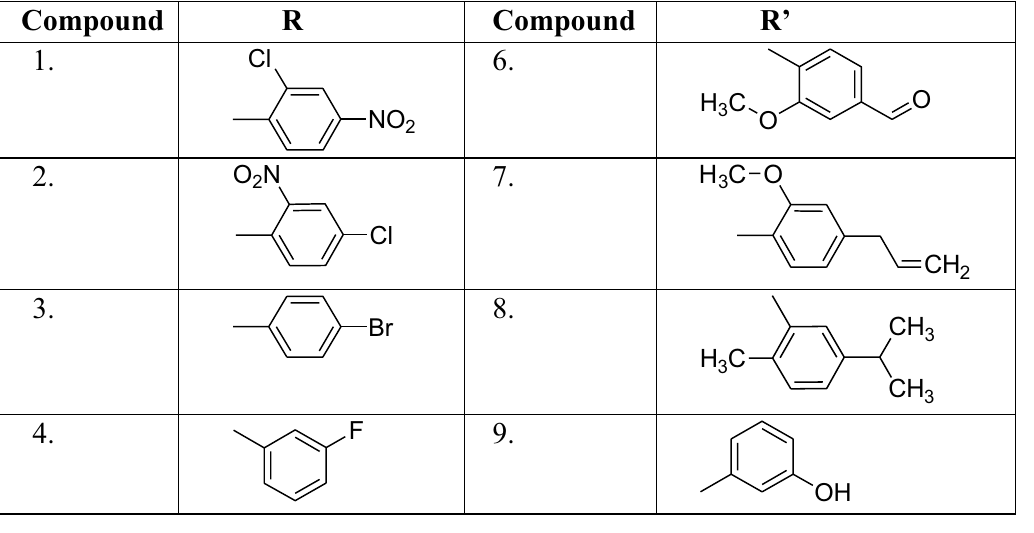
Table 3 Human MAO inhibitory activity of caffeic acid derivatives